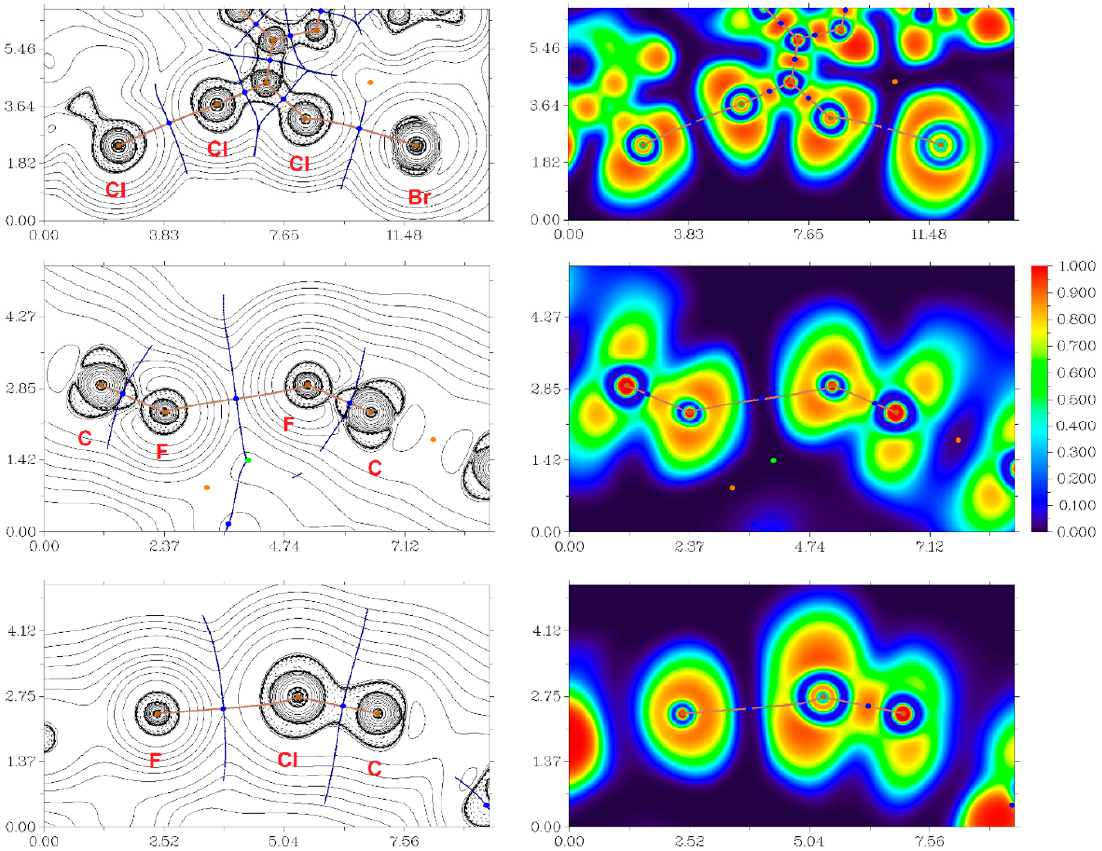
Figure 5. Contour line diagrams of the Laplacian of electron density distribution ∇ 2 ρ (r), bond paths, and selected zero-flux surfaces (left) and visualization of electron localization function (ELF) analysis (right) for intermolecular Cl ··· Br and Cl ··· Cl contacts in 15 (top); F ··· F (center) and Cl ··· F (bottom) contacts in 13 . Bond critical points (3, − 1) are shown in blue, nuclear critical points (3, − 3)—in pale brown, ring critical points (3, + 1)—in orange, cage critical points (3, + 3)—in light green, length units—Å, bond paths are shown as pale brown lines, and the color scale for the ELF maps is presented in a.u.